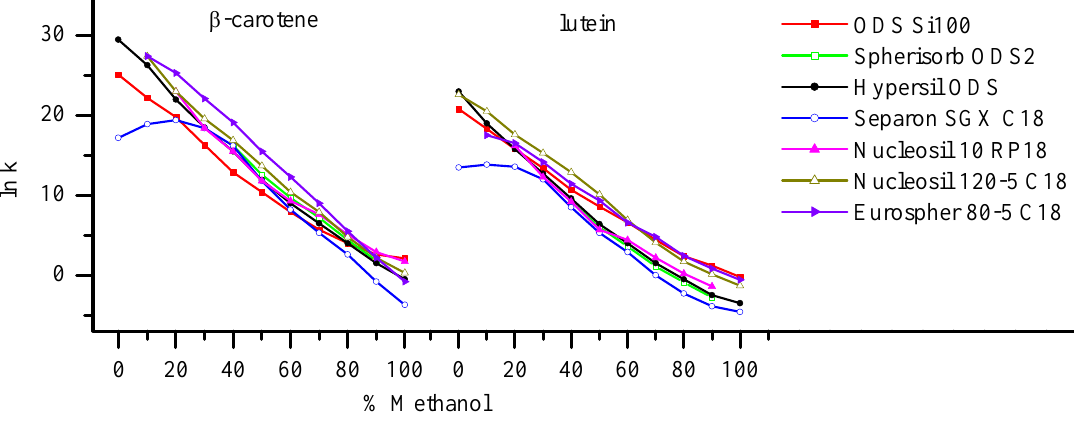
Figure 1. Dependence of the capacity factor k on commercial C18 columns in water-methanol.